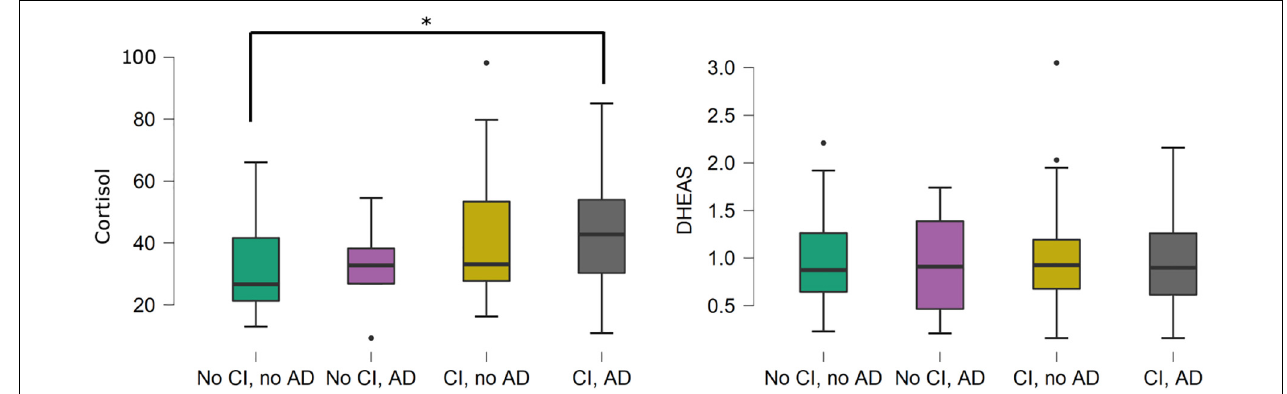
FIGURE 1 | Boxplots of cerebrospinal fluid cortisol and dehydroepiandrosterone sulfate levels in participants with/without cognitive impairment, and with/without a cerebrospinal fluid profile suggestive of Alzheimer’s disease. ∗ p = 0.001. Cerebrospinal fluid cortisol was significantly higher in the AD CI group compared to the no CI, no AD group. The other inter-group differences were not statistically significant. There were no statistically significant differences in cerebrospinal fluid dehydroepiandrosterone sulfate levels between the four groups defined by CI and AD status. Associations shown in this figure were not adjusted for covariates. AD, cerebrospinal fluid profile suggestive of Alzheimer’s disease; CI, cognitive impairment; DHEAS, dehydroepiandrosterone sulfate.